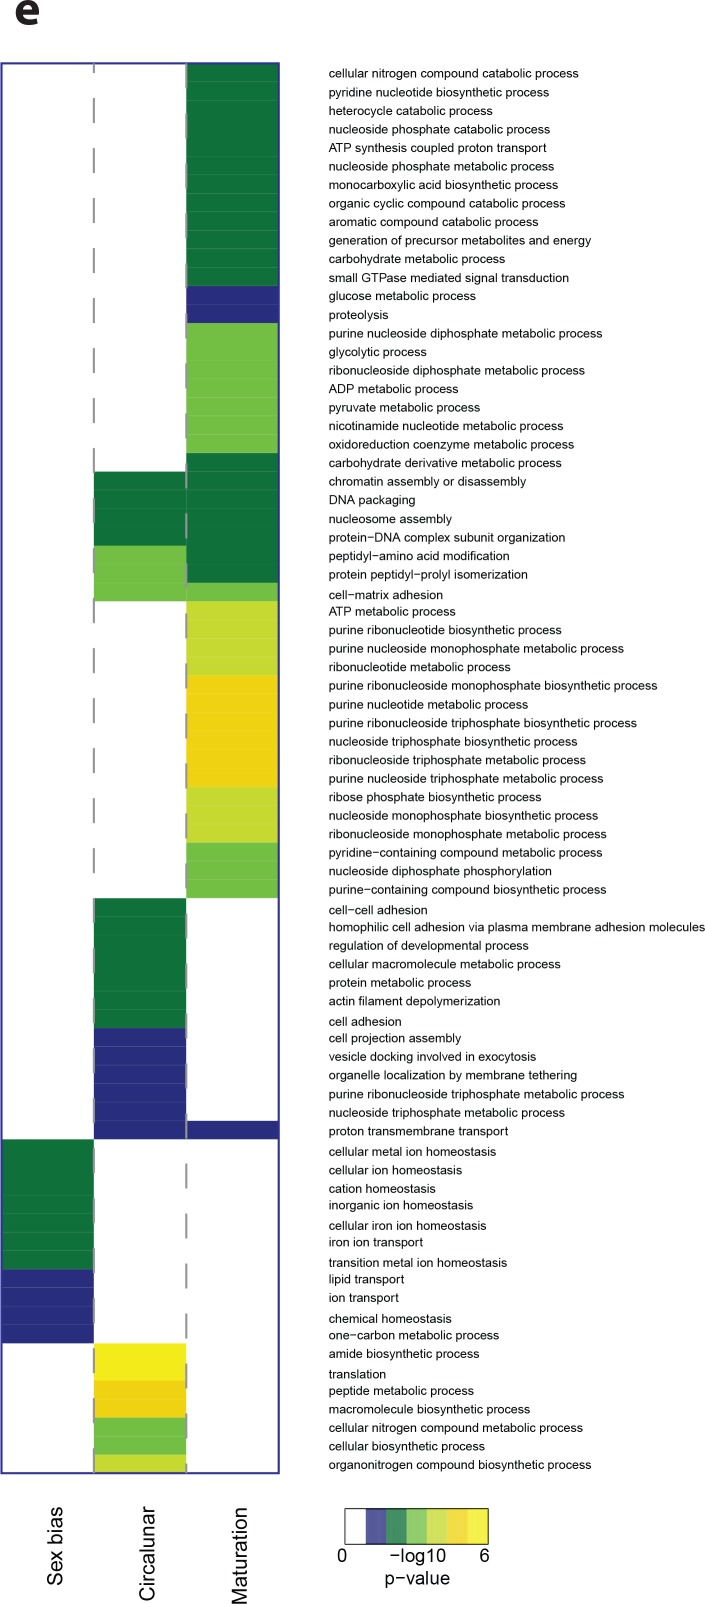
Heat map displaying over-represented GO-terms in the Biological Process Category.The heat map is subdivided (columns) by the regulation of each GO-term by circalunar clock phase (left), sex (middle) and/or maturation (right); colours are indicative of the enrichment p-value as calculated by a hypergeometric test implemented in the GOStats package.